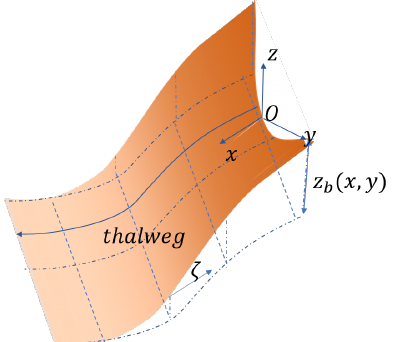
Figure 1. The sketch of curvilinear coordinates for Savage–Hutter